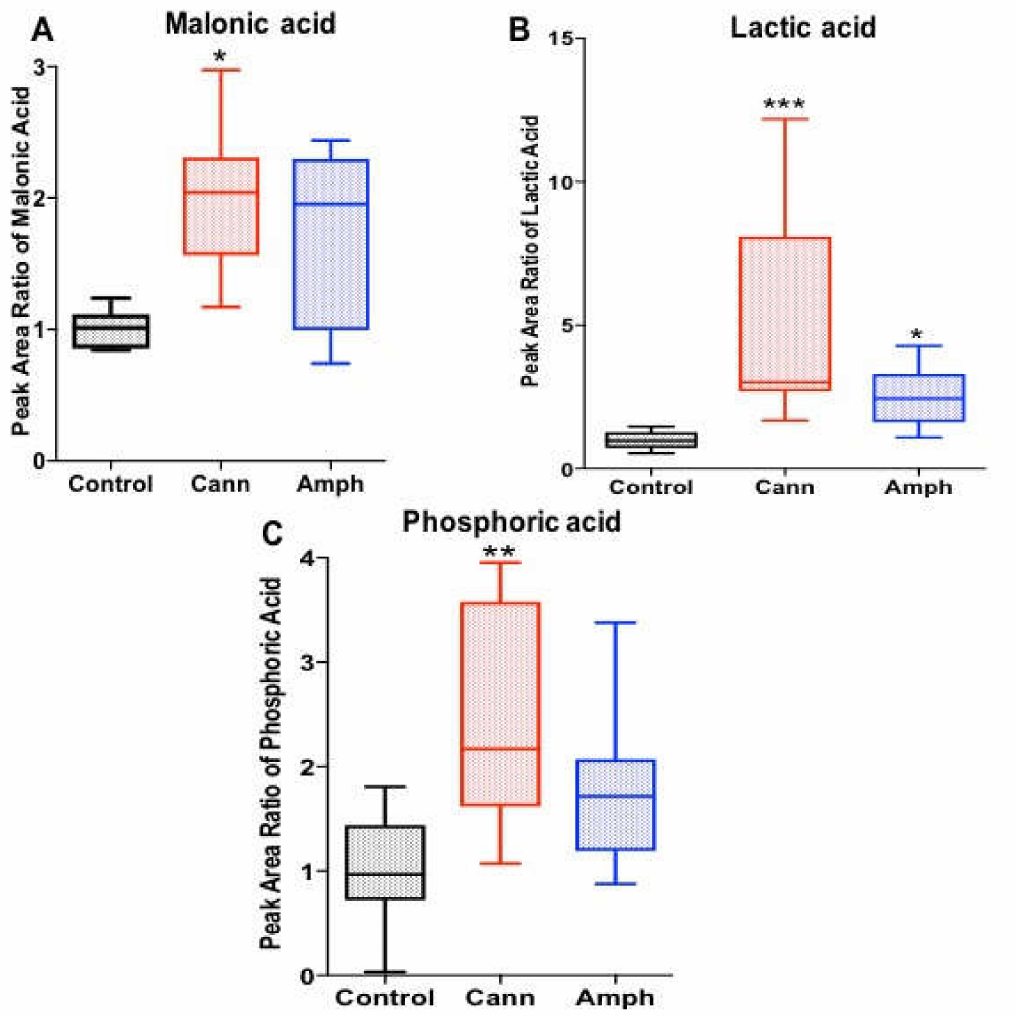
Figure 4. Effects of cannabis or amphetamine on malonic acid, lactic acid and phosphoric acid in cannabis or amphetamine use disorder patients. ( A ) Kruskal–Wallis test followed by Dunn’s post